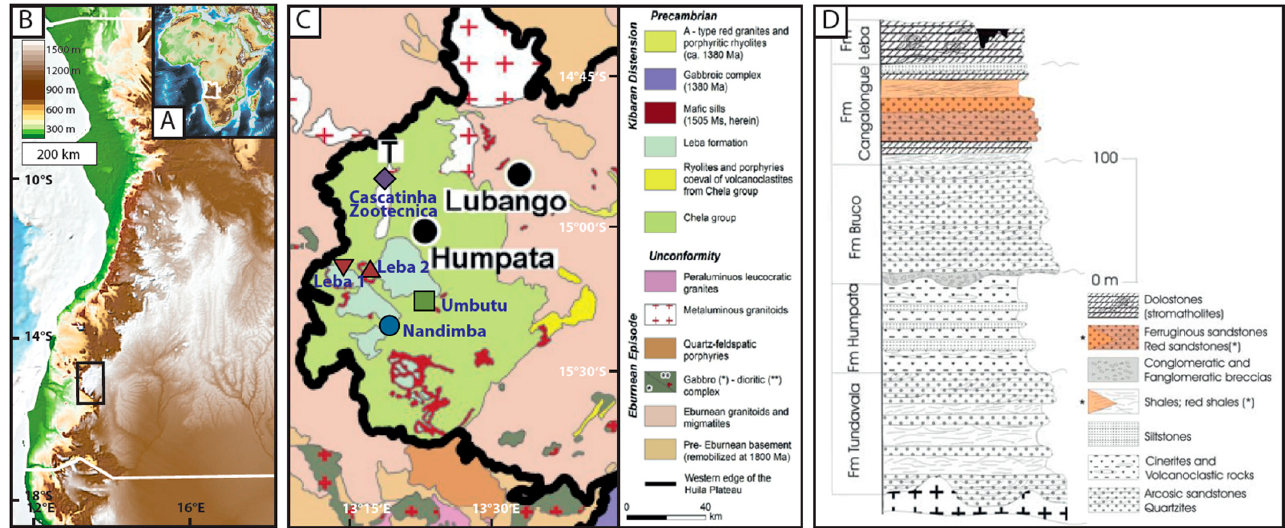
Figure 1. ( A ) Topographic map of Africa with Angola outlined in white. ( B ) Topographic map of western Angola with the study area outlined with a black box. ( C ) A close-up of the bedrock at the edge of the Humpata Plateau (Modified from Lopes et al., 2019) [18]. Sites from this study are added to the map and are located on the Leba Formation, Chela Group, or metaluminous granitoid. ( D ) A cross-section of the Chela Group, including the Leba and Cangalongue Formations on the Humpata Plateau (From Pereira et al., 2011) [21]. Asterisks (*) denote the shading for red shales and red sandstones.